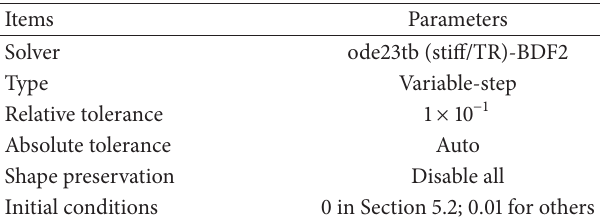
Table 1: Simulation conditions of solver